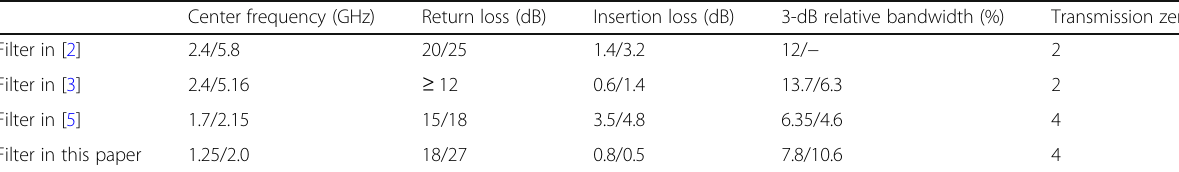
Table 1 Comparison with some prior dual-band